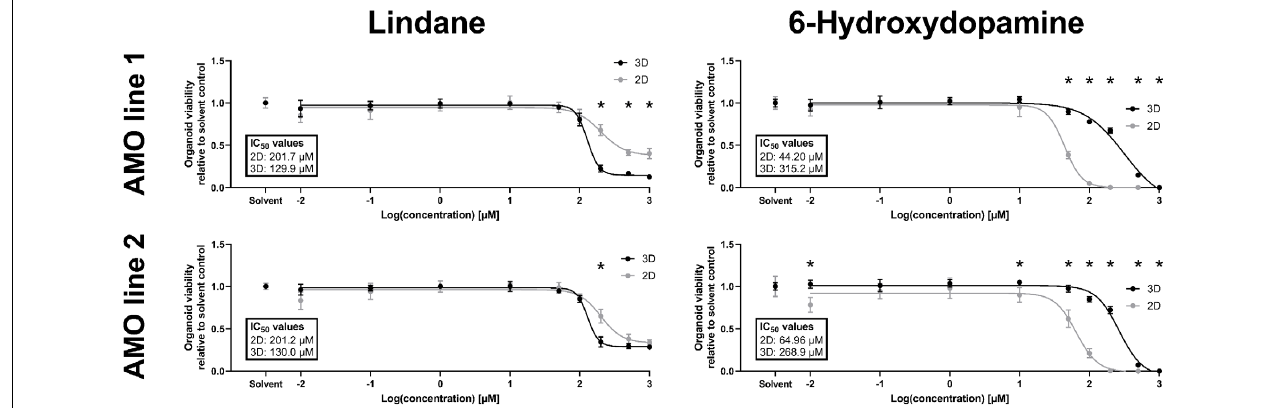
FIGURE 5 | The pesticide lindane is significantly more toxic in automated midbrain organoids than 2D-cultured dopaminergic neurons. While the well-established toxicant 6-hydroxydopamine (6OHDA, right column) was significantly more toxic in 2D (gray symbols) than 3D (black symbols), the toxicity of the pesticide lindane (left column) was significantly higher in 3D AMOs than 2D midbrain dopaminergic (mDA) neurons. We generated AMOs and mDA neurons from the same starting cell lines and batches, cultured them in parallel, and treated them with the compounds for 48 h starting on day 50 before measuring their viability. Data show viability relative to their corresponding solvent controls plotted against the log base 10 of the compound concentrations in µ mol/L. Graphs depict mean values ± SEM with n = 6 organoids per condition. Statistically significant differences between the 2D and 3D culture formats were determined via multiple unpaired t -tests, after correction for multiple testing, we considered p adj < 0.05 as significant (*). For details on curve fitting, IC50 calculations, as well as data and statistical analysis, see the “Materials and Methods”